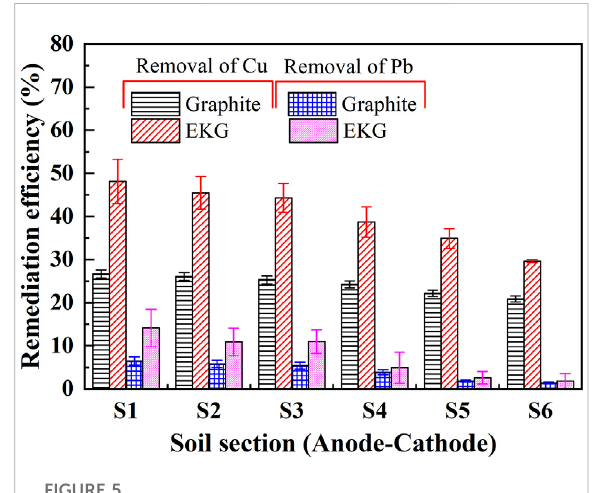
Removal of Cu and Pb after the electrokinetic experiment subjected to the effect of electrode